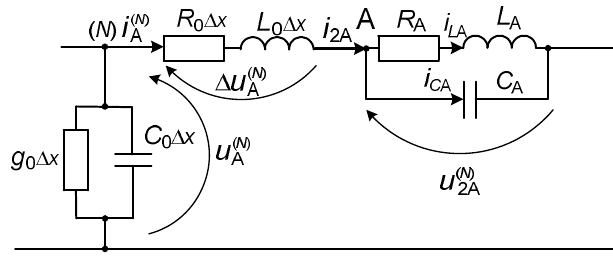
Figure 3. Schematic diagram of the phase A circuit of the simplified power system for the N-th discretization node at the end of the line.